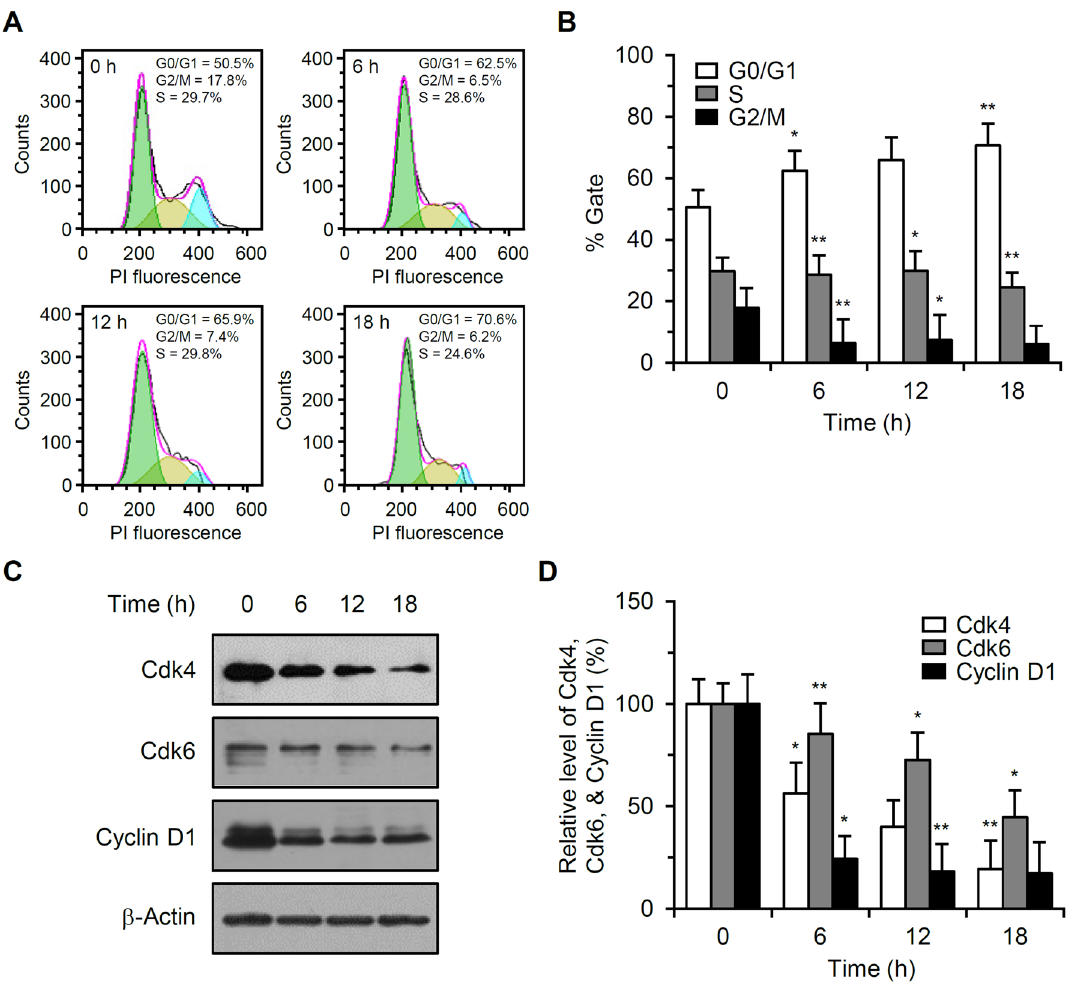
Figure 5. Effect of RF on cell cycle progression in HUVECs. ( A ) HUVECs were treated with 20 μM RF, viable cells were collected by trypsinization, and DNA content was analyzed after PI staining. ( B ) The percentages of cells in G0/G1, S, and G2/M phase in three independent experiments ( A ) are expressed as the mean ± SD; * p < 0.05, ** p < 0.01, compared to the control. ( C ) Protein extracts were prepared from cells treated with 20 μM RF, and Cdk4, Cdk6, and cyclin D1 levels were determined by western blotting. ( D ) Cdk4, Cdk6, and cyclin D1 levels were measured by ImageJ. Data from three independent experiments of ( C ) are presented as the mean ± SD; * p < 0.05, ** p < 0.01, compared to the control. Cdk4, Cdk6, and cyclin D1 levels in RF-untreated control cells were set to